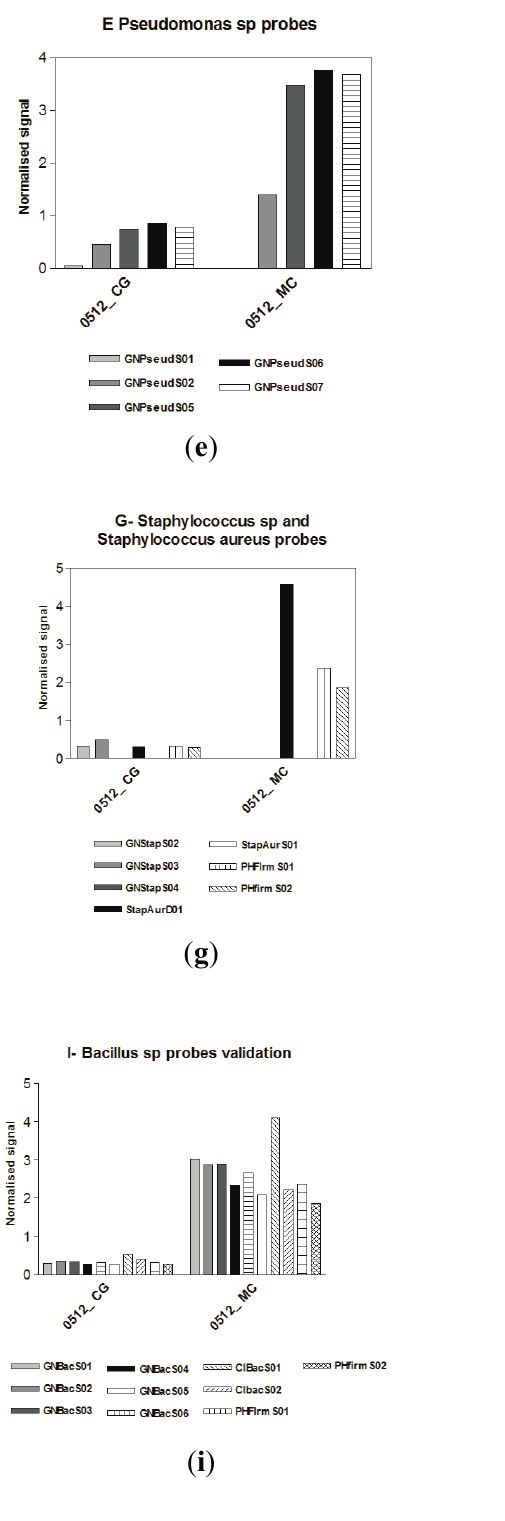
Figure 3. Probes for ( a ) Escherichia coli ; ( b ) Salmonella sp., ( c ) Yersinia sp. and Yersinia enterocolytica ; ( d ) Legionella spp. and Legionella pneumophila ; ( e ) Pseudomonas spp.; ( f ) Campylobacter spp.; ( g ) Staphylococcus and Staphylococcus aureus ; ( h ) Listeria spp.; ( i ) Bacillus spp.; ( j ) Family Vibrionaceae . Signal intensities of each probe were normalized with Dunaliella RNA 12.5 µM probe